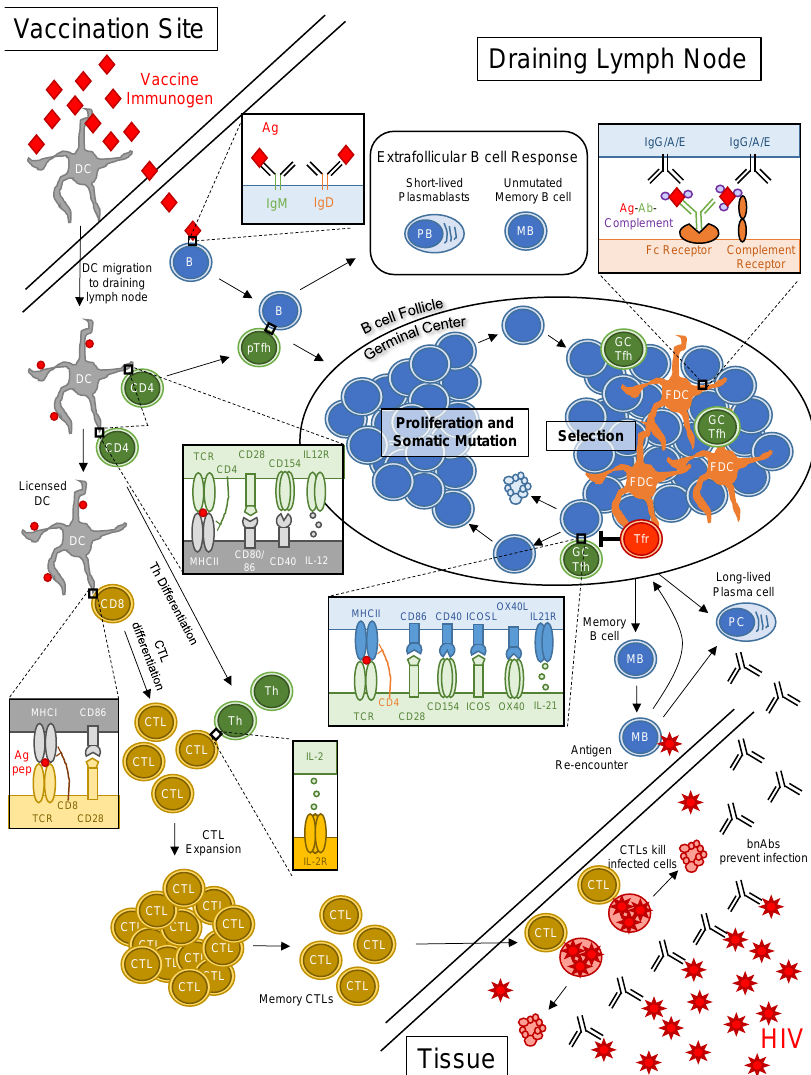
Figure 1. Eliciting humoral and cellular responses through vaccination. Vaccine immunogens prompt antigen-specific responses from B cells and T cells in draining lymph nodes. B cells are blue, CD8 + T cells are gold and CD4 + T cells are green. Some of the key molecular interactions between different cell types that are needed for optimal humoral and cellular defense are shown in boxes. For optimal humoral responses, antigen-specific B cells must interact with pre-TFH cells (“pTFH”) to initiate germinal center reactions. Within germinal centers, B cells proliferate and undergo somatic mutation, in which mutations are introduced into the genes encoding the B cell receptor, thereby enhancing or diminishing affinity for antigen. B cells bearing receptors that have acquired affinity through mutation interact with TFH cells to receive sur- vival signals and re-enter the cycle of proliferation and mutation. Germinal centers produce long-lived plasma cells, which